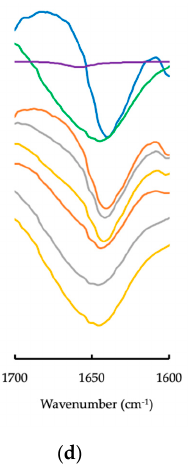
Figure 3. FT-IR spectra of samples. ( a ) PMs and GMs with HPC-SSL in various mixing ratios (grinding time: 45 min); ( b ) PMs and GMs with HPC-SSL in various mixing ratios (grinding time: 45 min) from 1600 to 1680 cm − 1 ; ( c ) PMs and GMs with PVP K30 in various mixing ratios (grinding time: 30 min); ( d ) PMs and GMs with PVP K30 in various mixing ratios (grinding time: 30 min) from 1600 to 1680 cm − 1 .